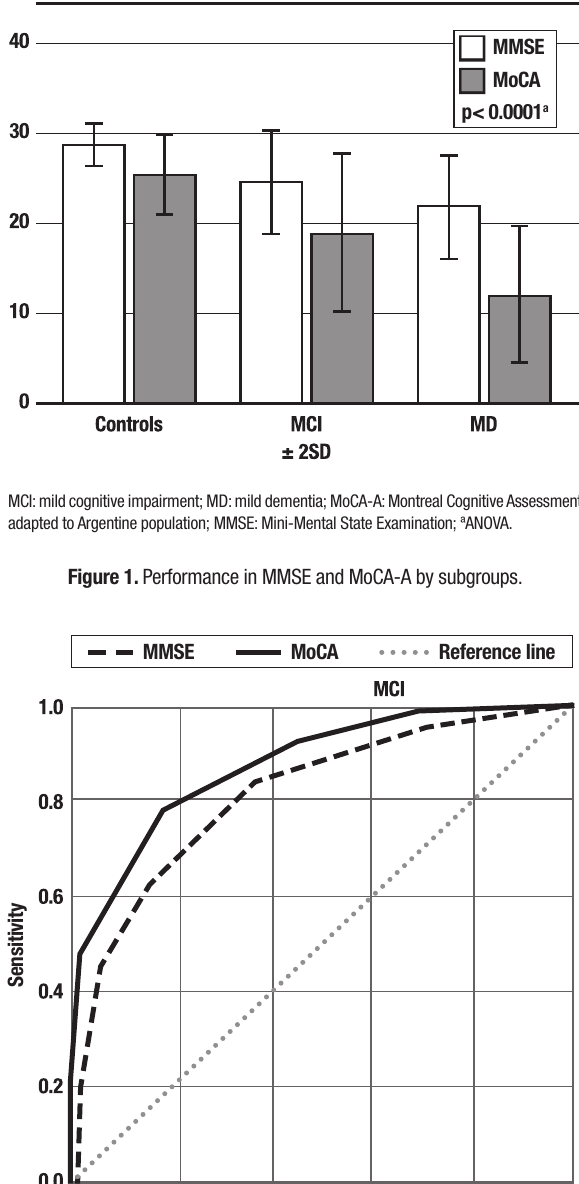
Table 4. Cutoffs for the MoCA total score by age and education level.